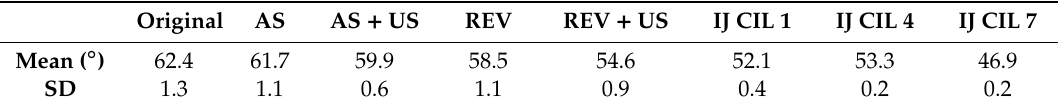
Table 3. Contact angle of the crystallized products measured at 5 s, when the values of SD was set to a constant minimum.